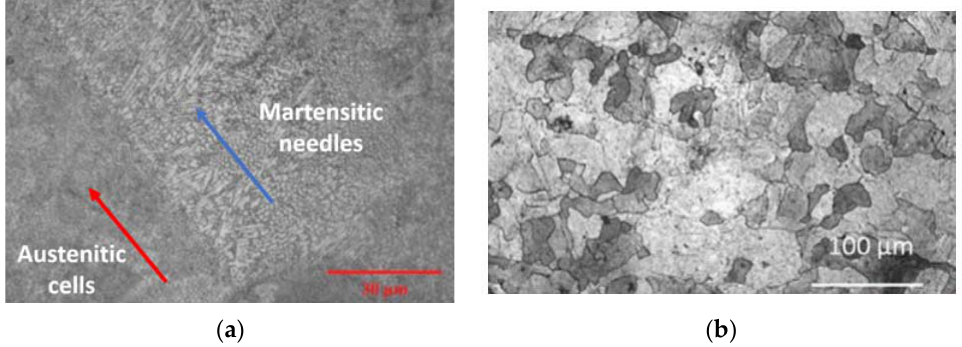
Figure 24 . ( a ) Surface microstructure of SLM printed stainless steel directly from the substrate [43] and ( b ) SLM printed stainless steel microstructure following 1100 °C heat treatment